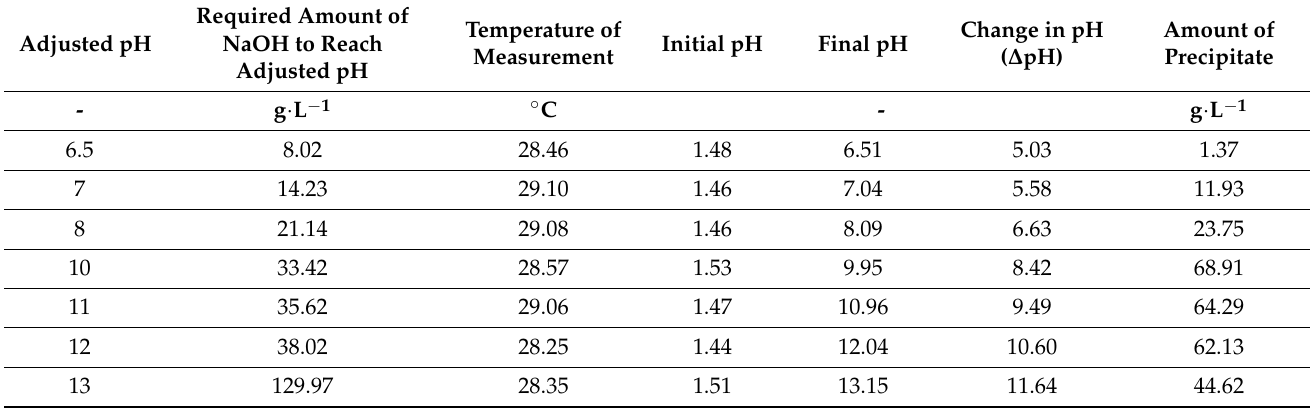
Table 6. Conditions of pH and amount of NaOH during precipitation of zinc and manganese from solution after non-selective leaching.